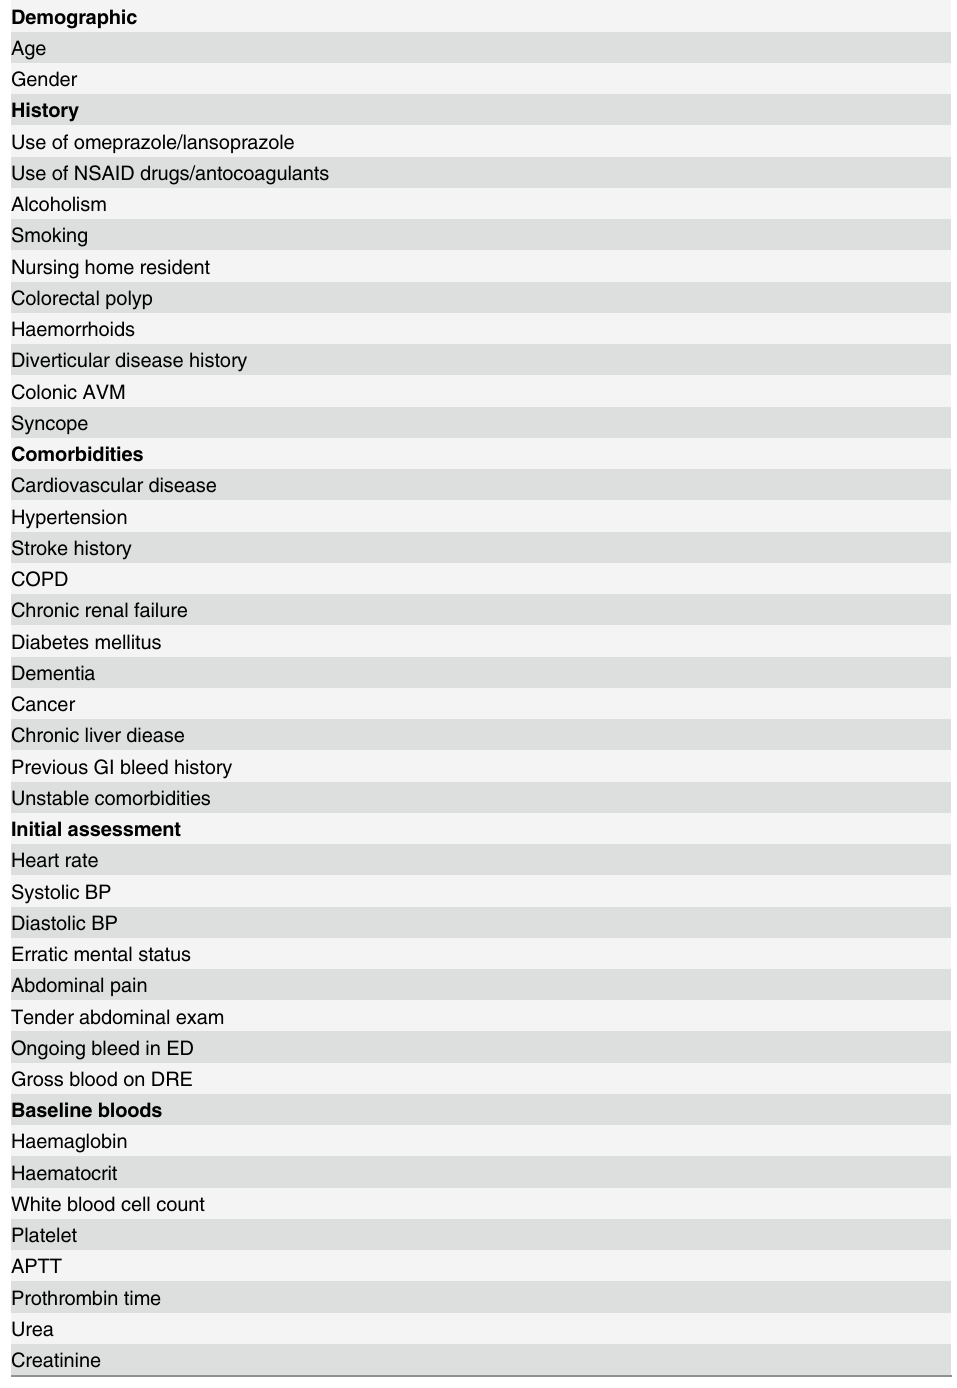
Table 1. Baseline Variables at initial ALGIB